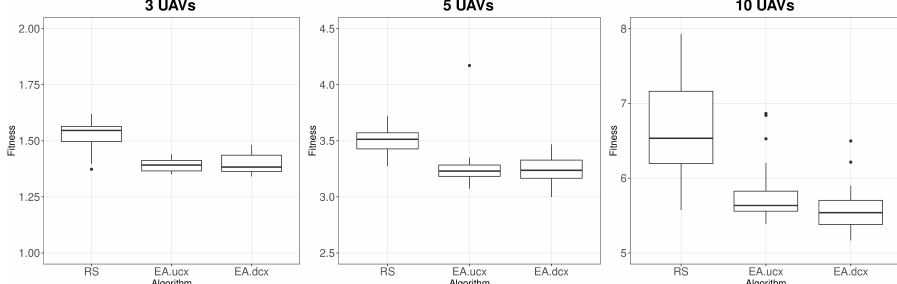
Figure 9. Boxplots showing the distribution of the optimisation results.